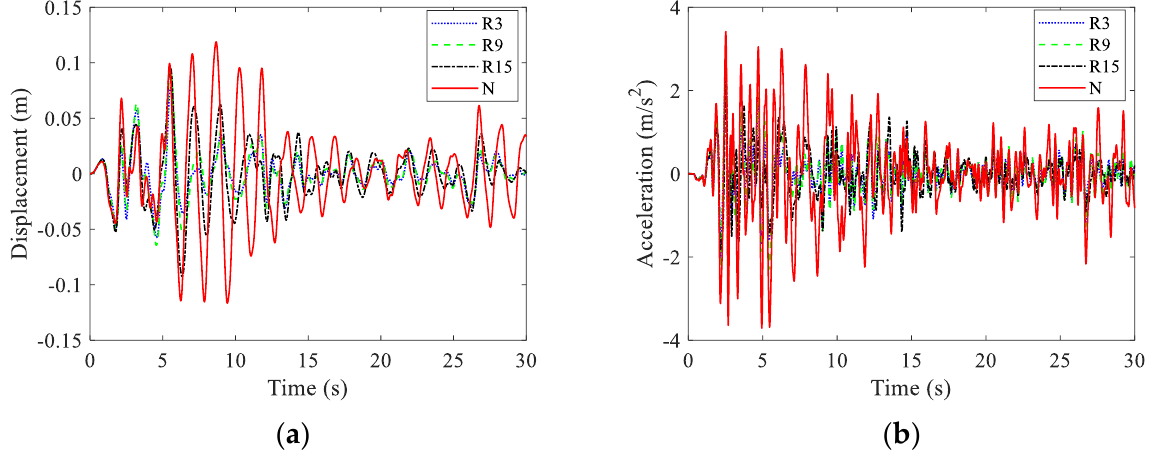
Figure 16. Top response of model 1 (El Centro): ( a ) displacement; ( b ) absolute acceleration.